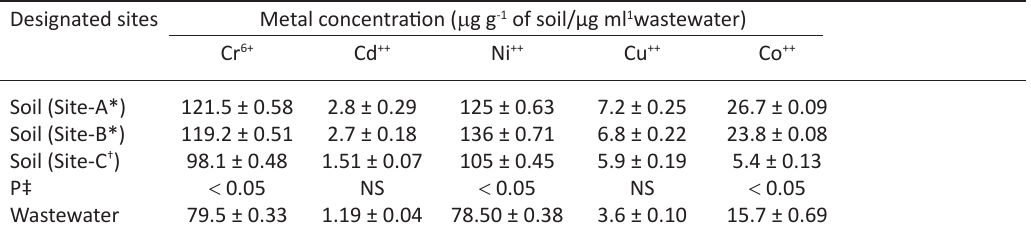
Table 1a. Heavy metal analysis of wastewater and wastewater irrigated soils Designated sites